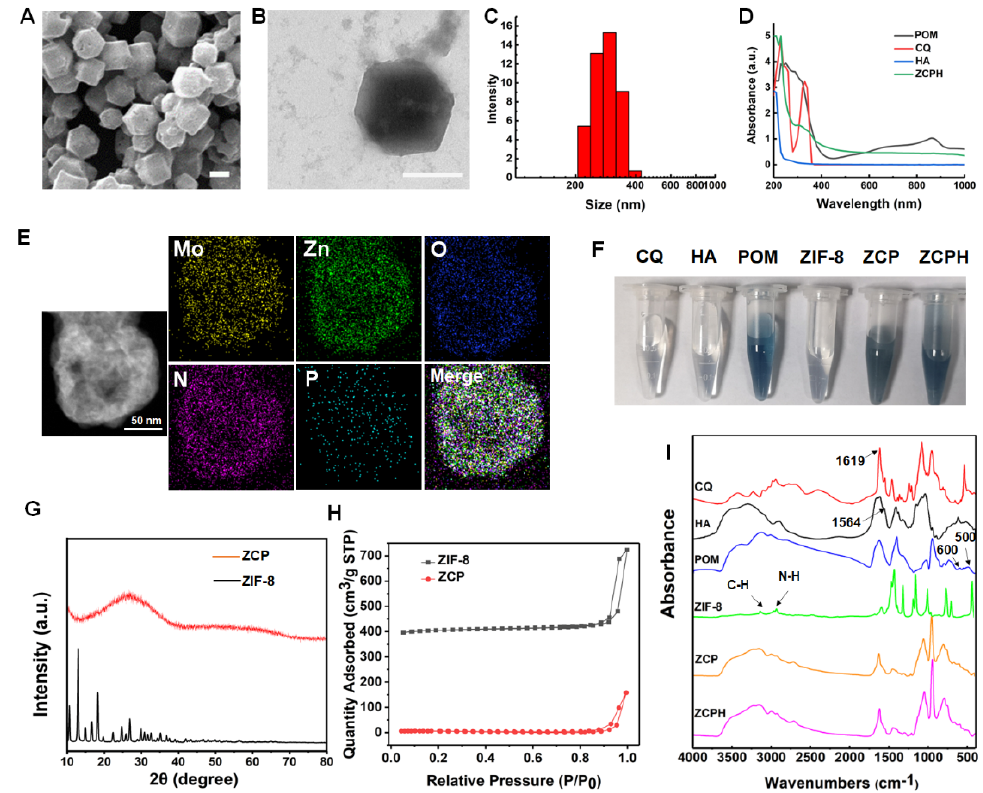
Figure 2. ( A ) SEM images of ZCPHs. ( B ) TEM images of ZCPHs. ( C ) Size distribution of ZCPHs. ( D ) UV-vis-NIR spectra of different groups. ( E ) TEM mapping images of ZCPHs. ( F ) Colors of CQ, HA, POM, ZIF-8, ZCP and ZCPH. ( G ) XRD patterns of the simulated ZIF-8 and ZCP. ( H ) N 2 absorption-desorption isotherms of ZIF-8 and ZCP. ( I ) FT-IR spectra of CQ, HA, POM, ZIF-8, ZCP and ZCPH. Scale bar: 200 nm.